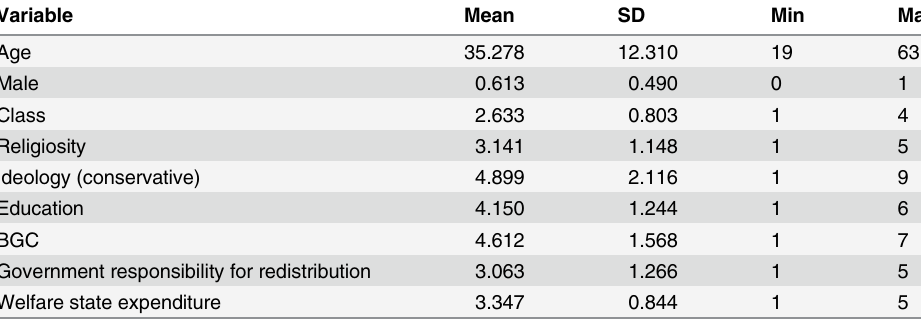
Table 5. Descriptive statistics, American Catholic sample (Study 3).